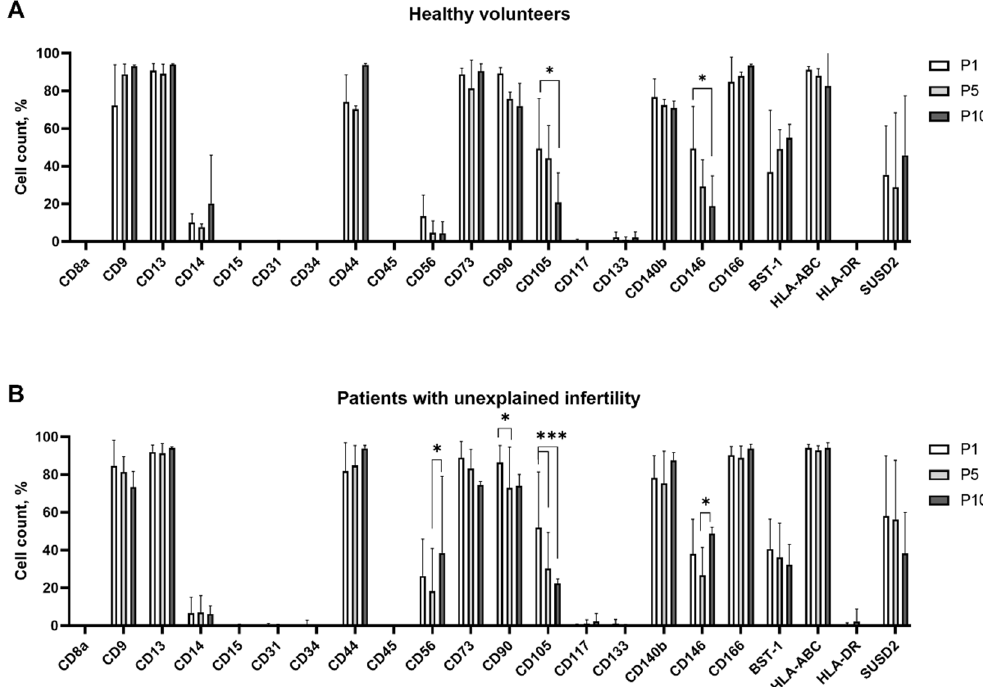
Figure 1. Analysis of cell surface markers of MenSCs. ( A )—from healthy volunteers, ( B )—from patients with unexplained infertility. The expression of mesenchymal cell surface markers CD9, CD13, CD44, CD56, CD73, CD90 CD105, CD140b, CD166, BST-1 and SUSD2; hematopoietic and endothelial cell markers CD8a, CD14, CD15, CD31, CD34, CD45, CD117 CD133 and CD146; as well as MHC class I and II cell surface receptors, HLA-DR and HLA-ABC were measured using flow cytometry at different passages (p1, p5 and p10) of MenSCs. Results are presented as mean ± S.D. (n ≥ 5). Note: * denotes a significant difference between MenSCs at p1 and subsequent passages with p < 0.05, *** denotes a significant difference with p < 0.005, as evaluated using mixed-effects analysis with Tukey’s multiple comparison test.